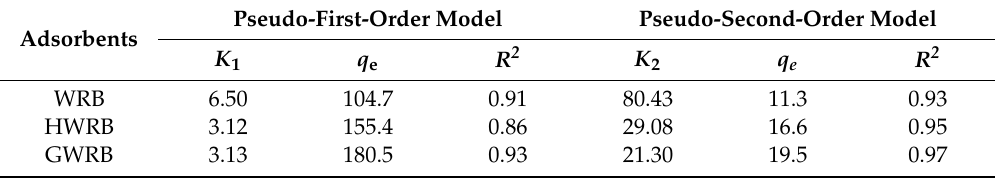
Table 3. The parameters and correlation coe ffi cients of adsorption kinetics.